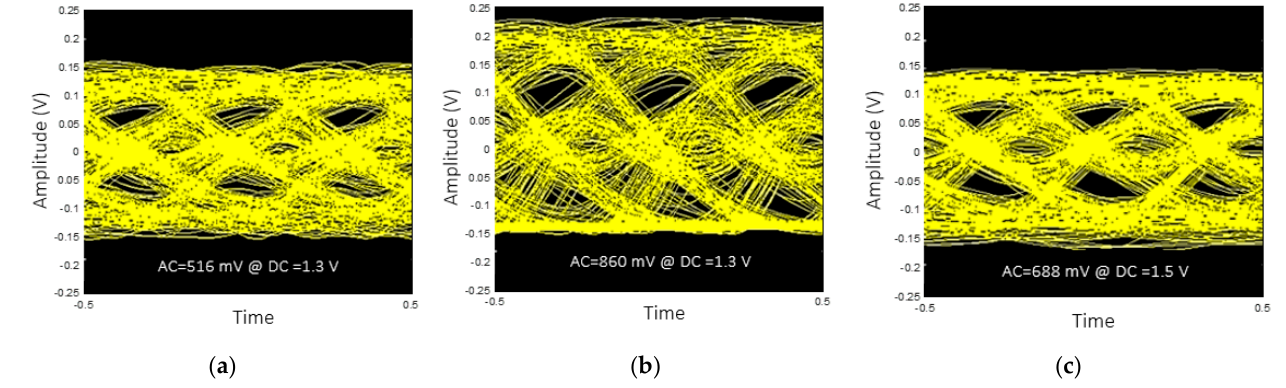
Figure 6. Eye-diagram of the received 2-PAM signal of 3 Gbps applying ( a ) 516 mV AC with 1.3 V DC, ( b ) 860 mV AC with 1.3V DC, ( c ) 688 mV AC with 1.5 DC.